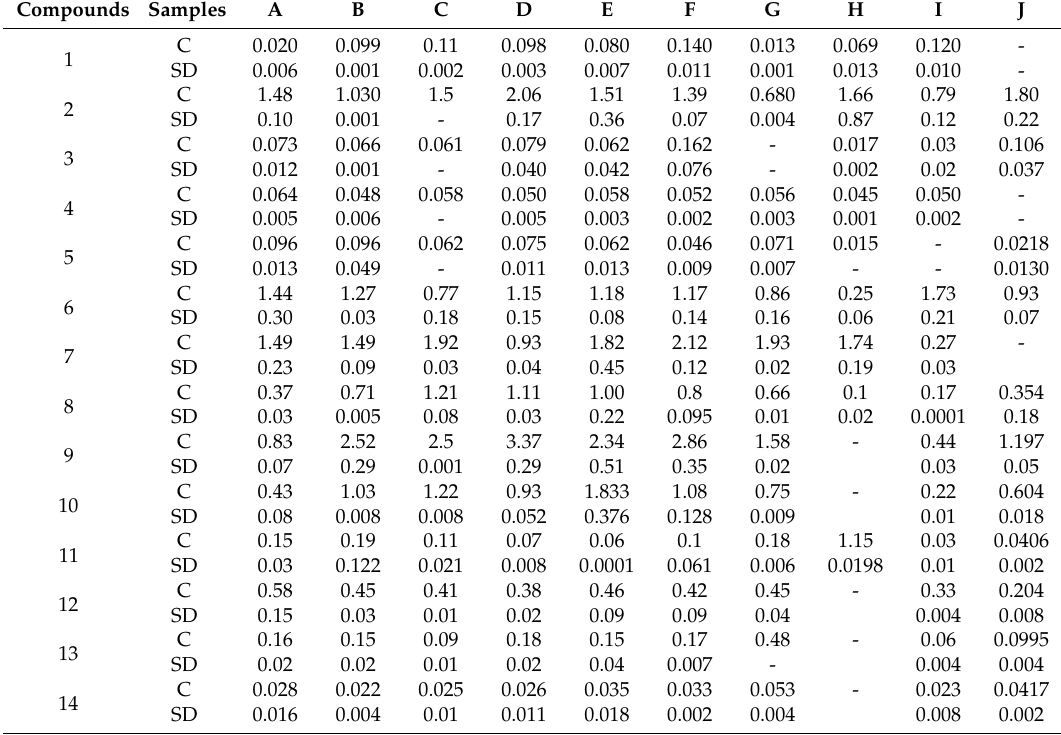
Table 2. Content of the studies compounds in the samples listed in Table